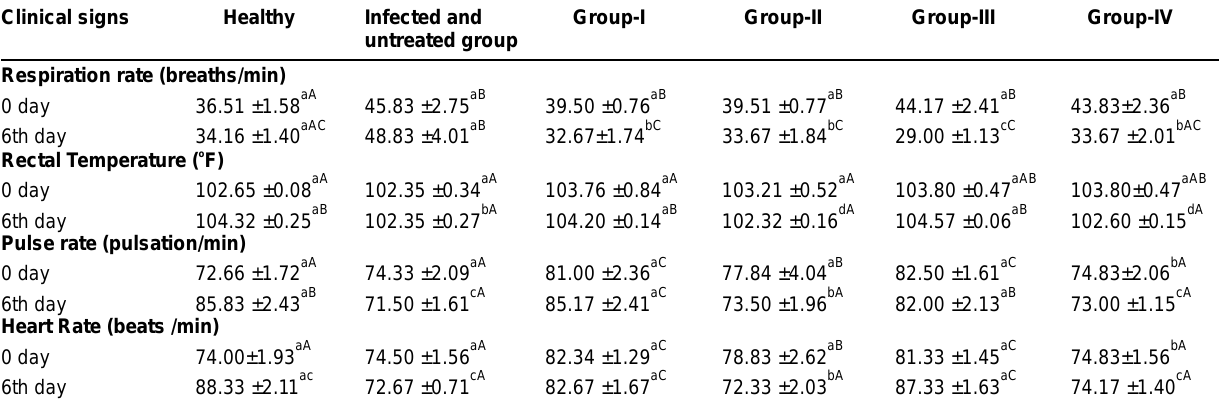
Table-2: Difference in clinical signs before and after treatment Clinical